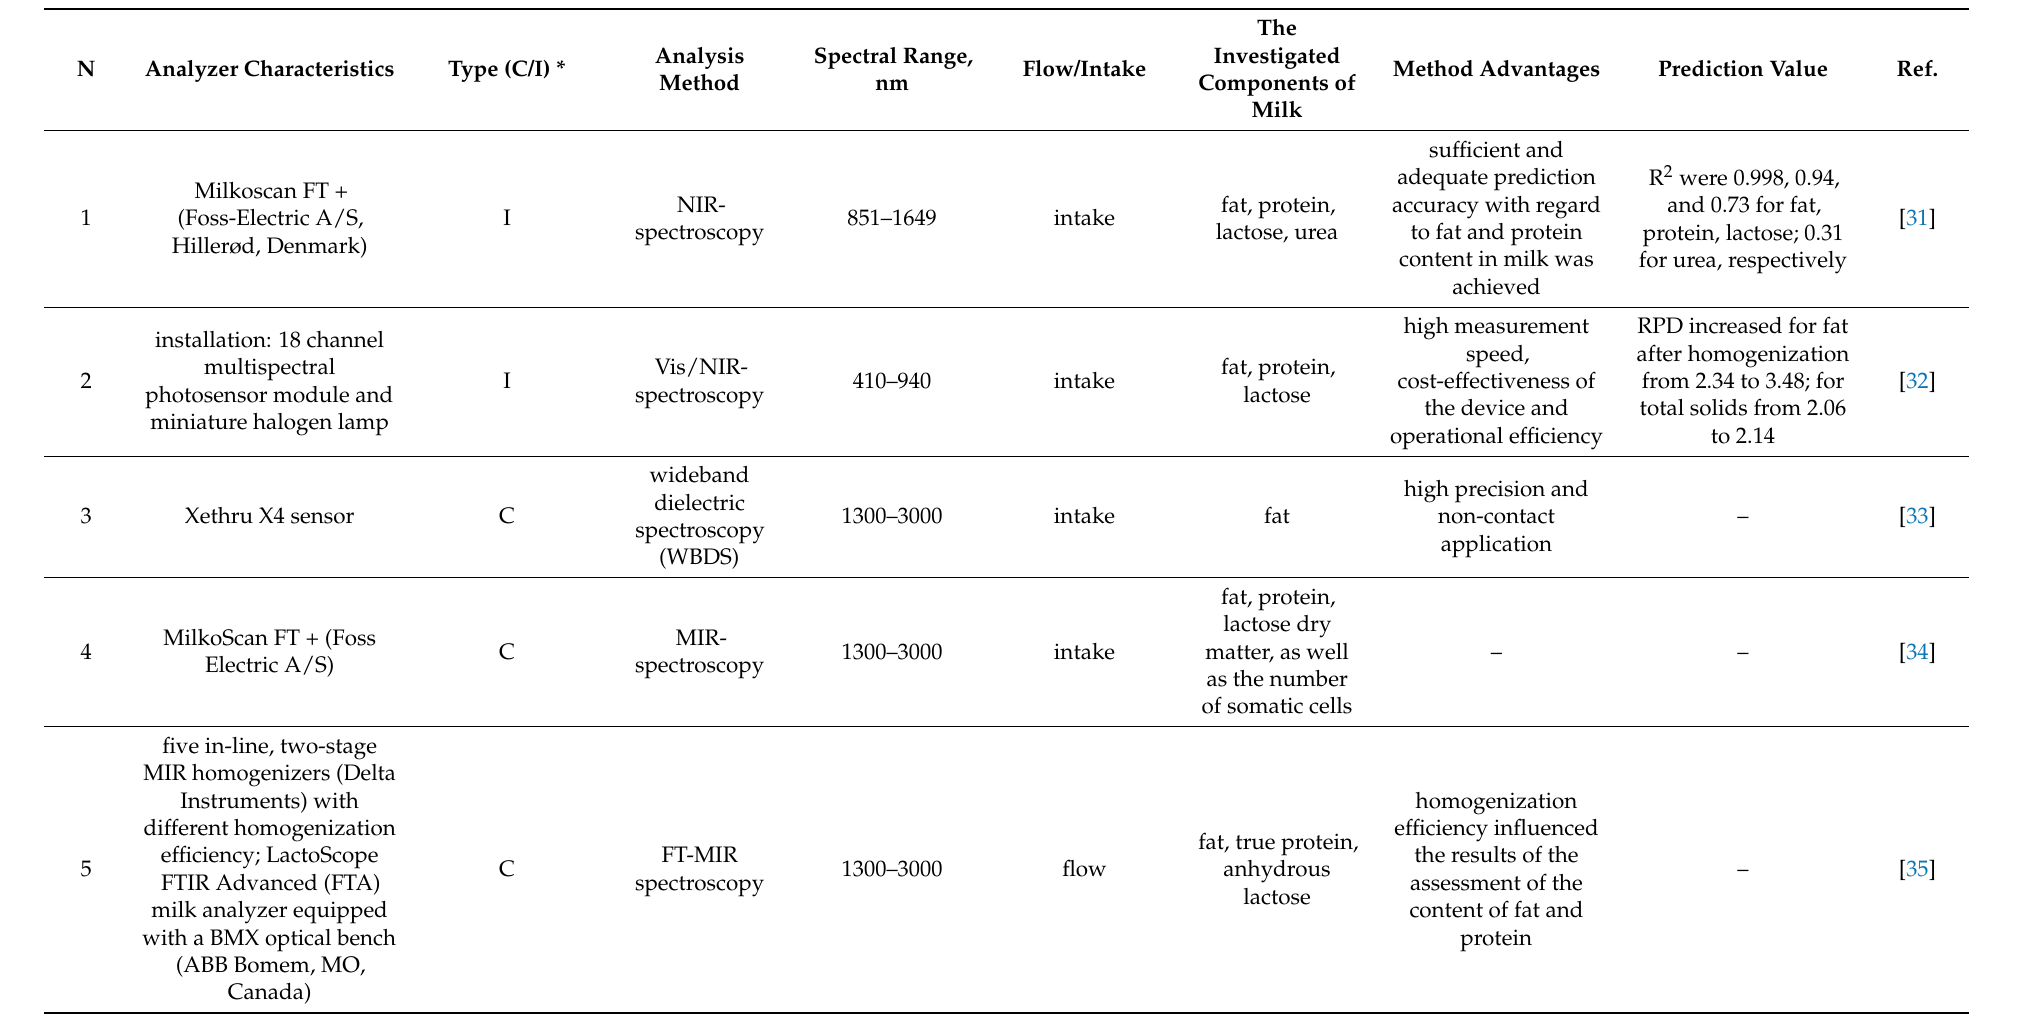
Table 1. Main characteristics of optical methods and devices used to assess the quality of